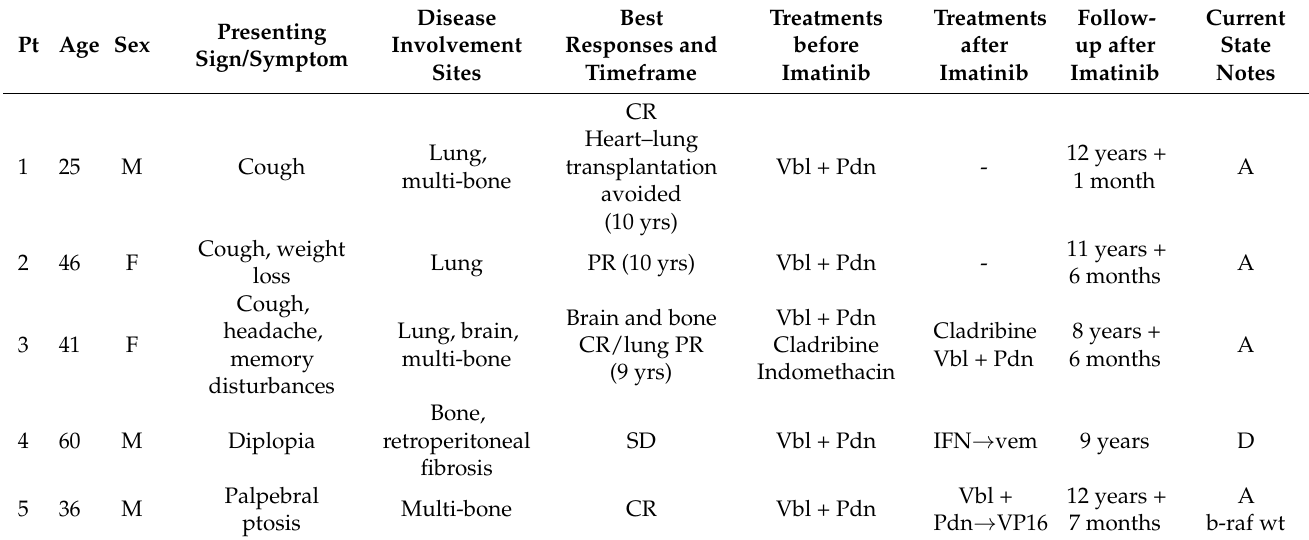
Table 2. CR: complete response; PR: partial response; SD: stable disease; A: alive; D: dead; yrs: years; vem: vemurafenib; VP16: etoposide; BS: 99m Tc bone scintigraphy; CNS: central nervous system; CT: computed tomography; CUT: